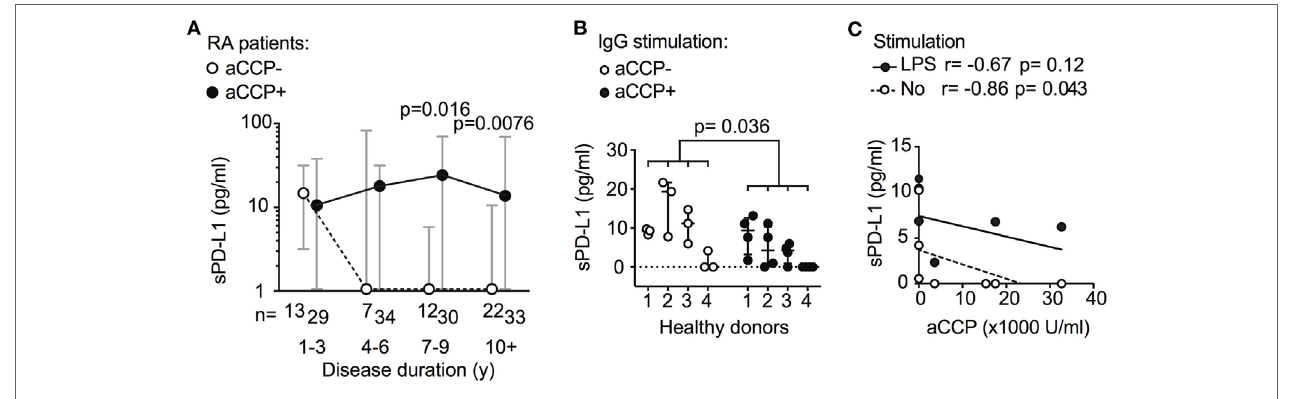
FigUre 2 | Antibodies against anti-cyclic citrullinated peptides (aCCP) influence production of soluble PD-L1 (sPD-L1). (a) sPD-L1 in serum of aCCP + and aCCP − RA patients, stratified by disease duration. Dots represent the median and whiskers represent the interquartile range. (B) sPD-L1 measured in lipopolysaccharide (LPS) stimulated cultures of peripheral blood monocytes from aCCP − healthy controls exposed to IgG of aCCP + and aCCP − RA patients. The Mann–Whitney U test was applied. (c) Spearman’s rank correlation test between sPD-L1 in supernatant of healthy peripheral blood mononuclear cells cultures and aCCP content in serum of the patients from which the IgG was isolated. Cells were cultured with or without LPS stimulation. Circles